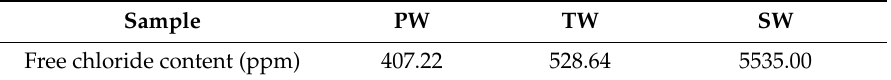
Table 6. Free chloride content in AAM mixes obtained by ion